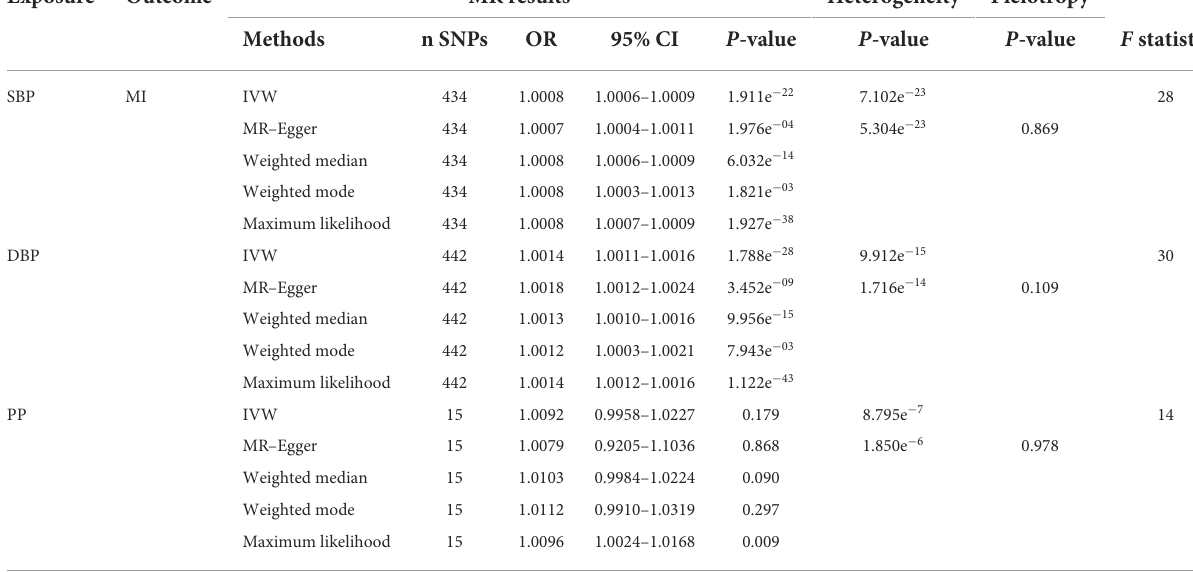
TABLE 1 Summary of forward MR results of pressure and myocardial infarction.